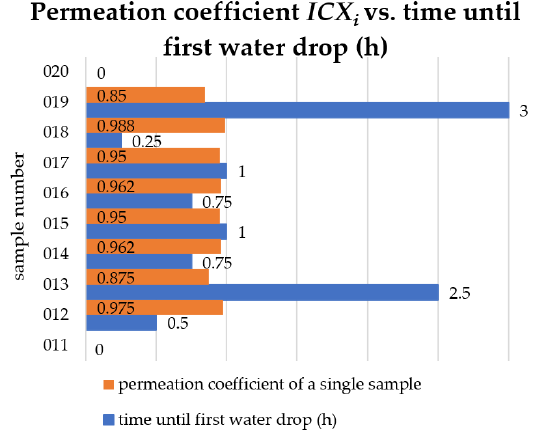
Figure 10. Permeation coefficient.